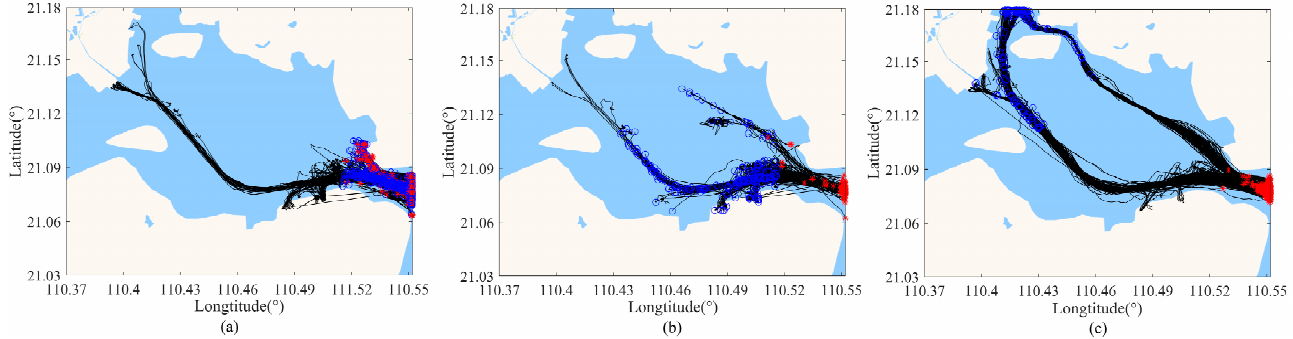
Figure 9. Trajectories with departures mainly near Area 4. ( a ) Area 1 to Area 1, 609; ( b ) Area 1 to Area 2, 256; ( c ) Area 1 to Area 4, 388.